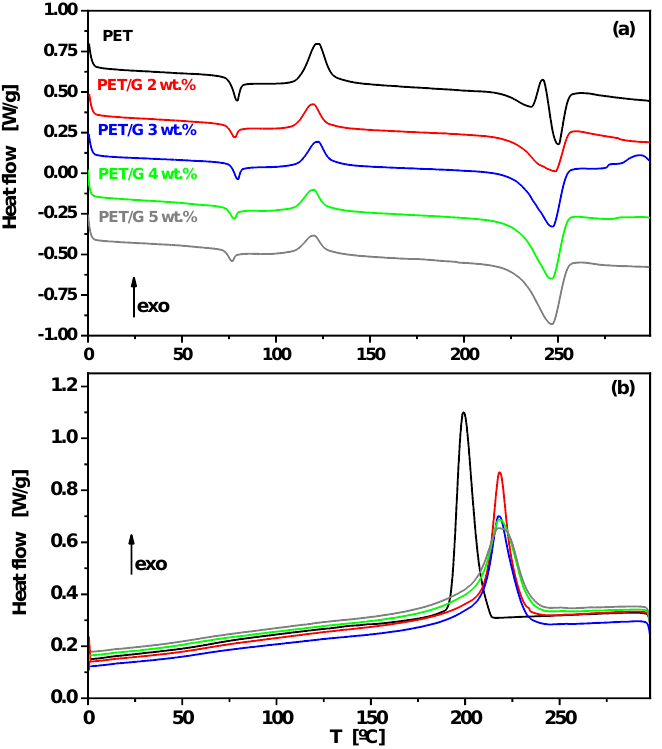
Figure 8. DSC heating scan for PET fibers ( a ) and subsequent cooling scan ( b ).